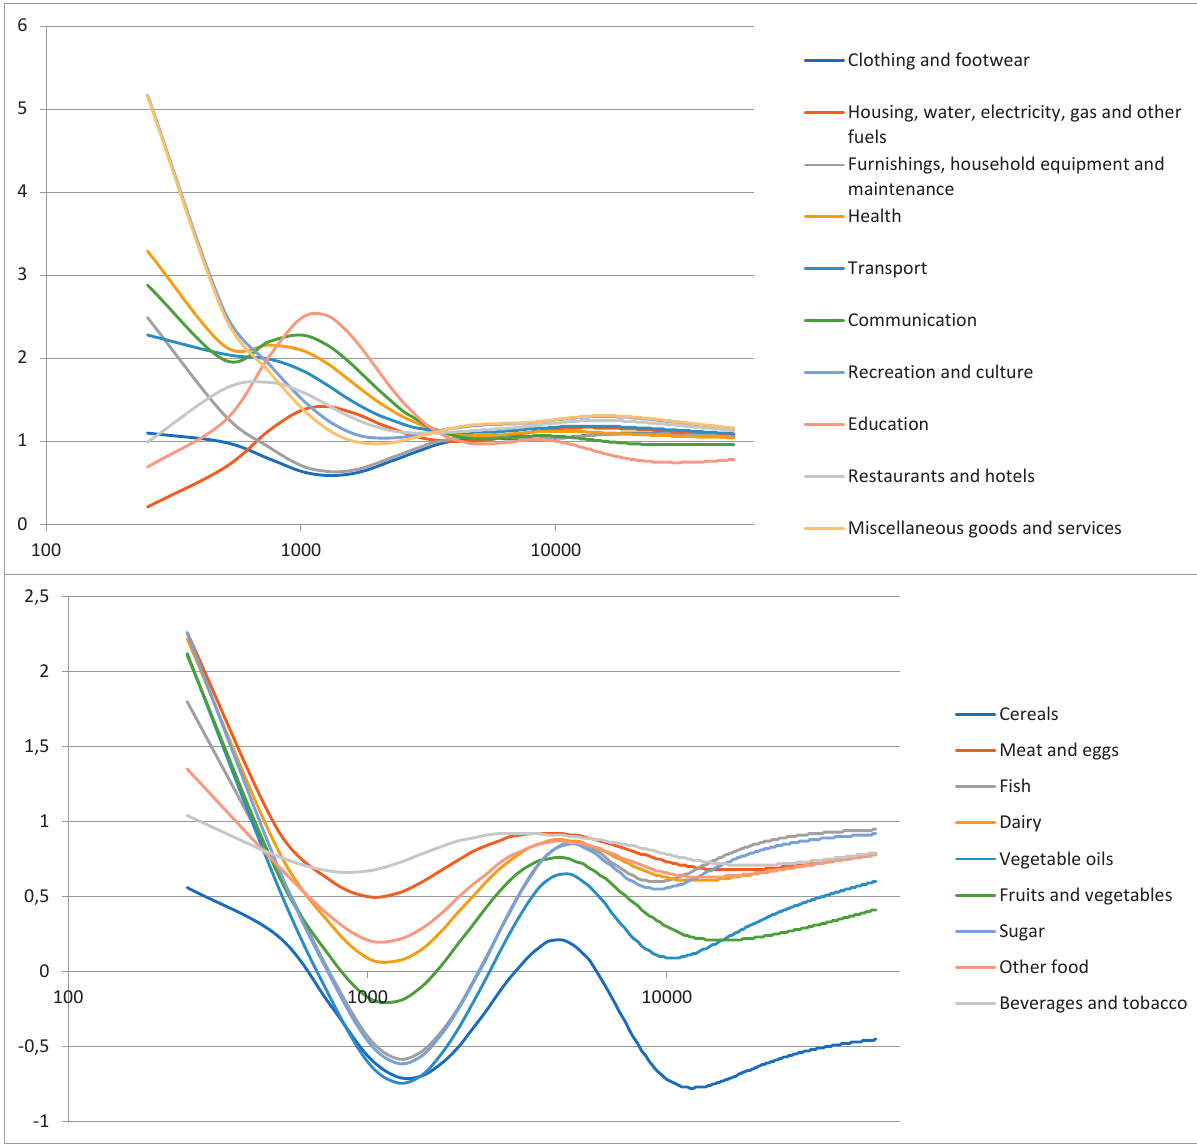
Figure 5. Estimated Engel elasticities at mean prices. Note: Calculated at mean sample prices and mean sample values of the additional fac- tors. Formula based on Preckel et al.